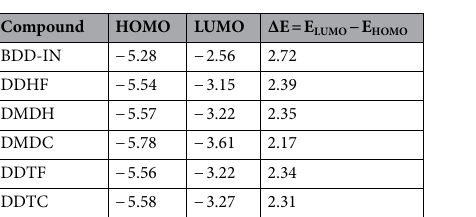
Figure 3. Optimized structures of studied compounds are made with the help of GaussView 5.0 and Gaussian 09 version D.01 (https:// gauss ian. com/ g09ci tation/) Cartesian co-ordinates of all the molecules are presented in Supplementary Tables S1, S2, S3, S4, S5 and S6.